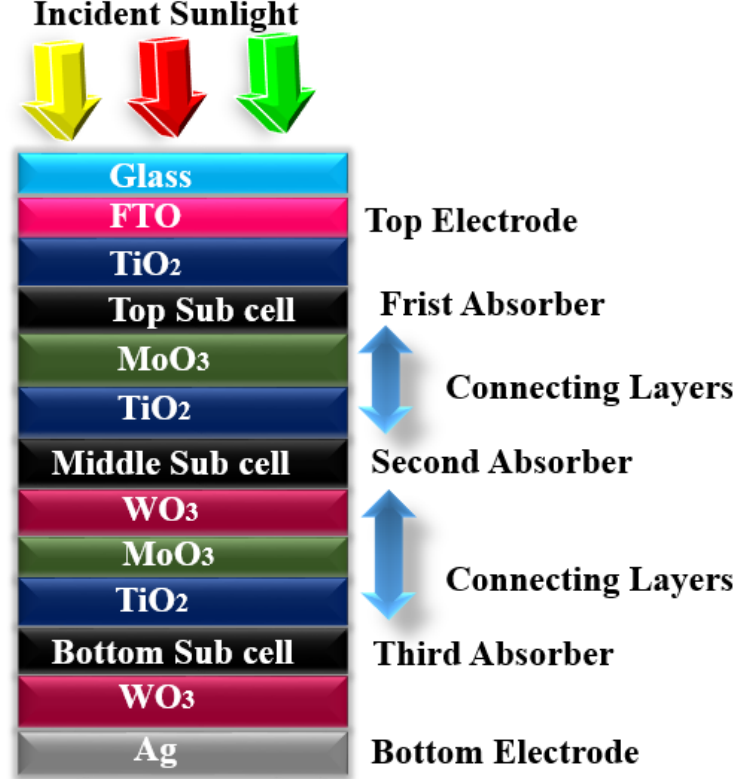
Figure 1. Configuration of a proposed structure.